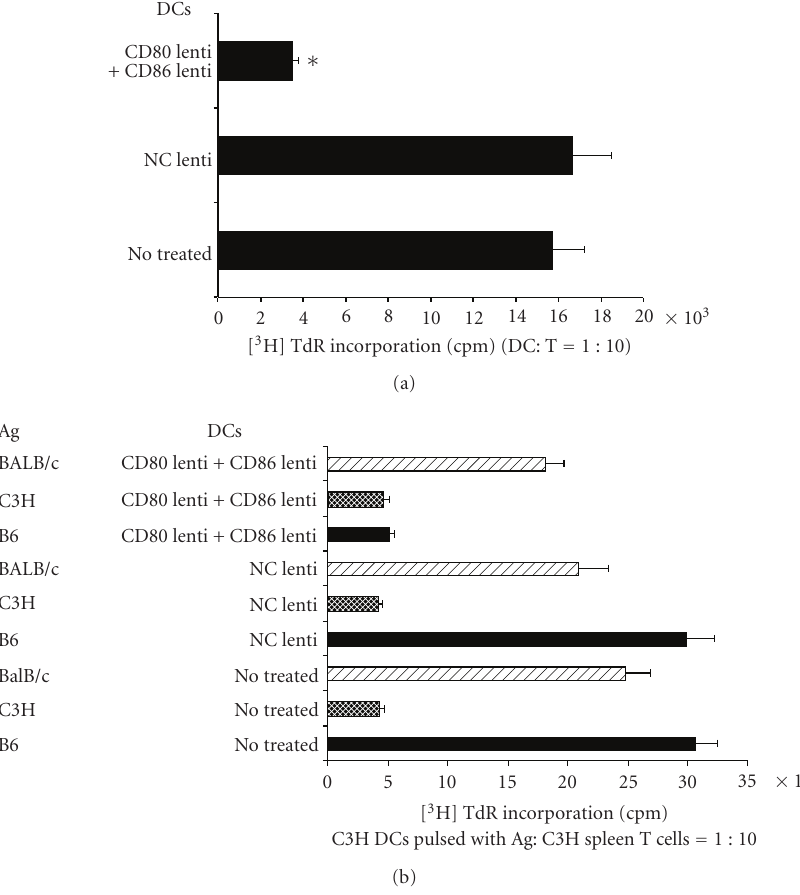
Figure 4: (a) B6 alloAg-pulsed, CD80 lenti - and CD86 lenti -transduced DCs were inferior stimulators of na¨ıve syngeneic C3H T cells, compared to alloAg-pulsed NC lenti -transduced DCs or no treated DCs. ∗ P < . 05 compared to NC lenti /No treated. (b) DCs loaded with debris B6 spleen cells were injected into syngeneic C3H mice (3 × 10 6 /mouse). Seven days later, recipients were sacrificed and splenic T cells challenged ex vivo with γ -irradiated C3H DCs pulsed with Ag (BALB/c, C3H, or B6 splenocyte lysates). Data are expressed as cpm ± 1SD from triplicate cultures and are representative of four separate